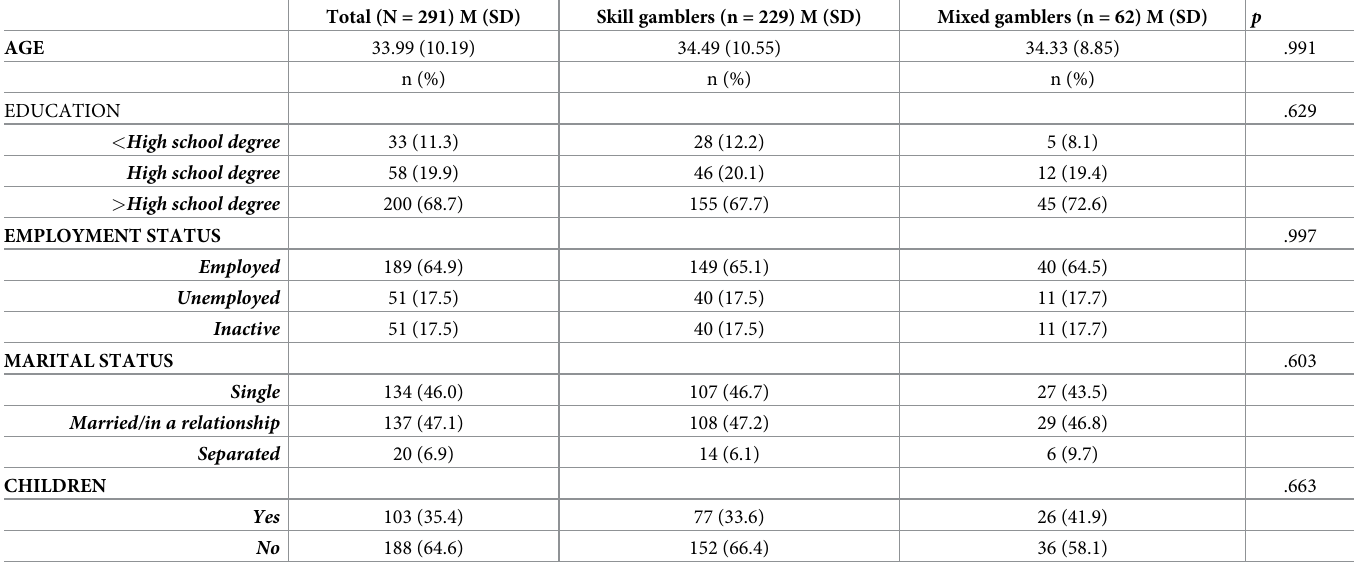
Table 1. Sociodemographic characteristics of skill and mixed